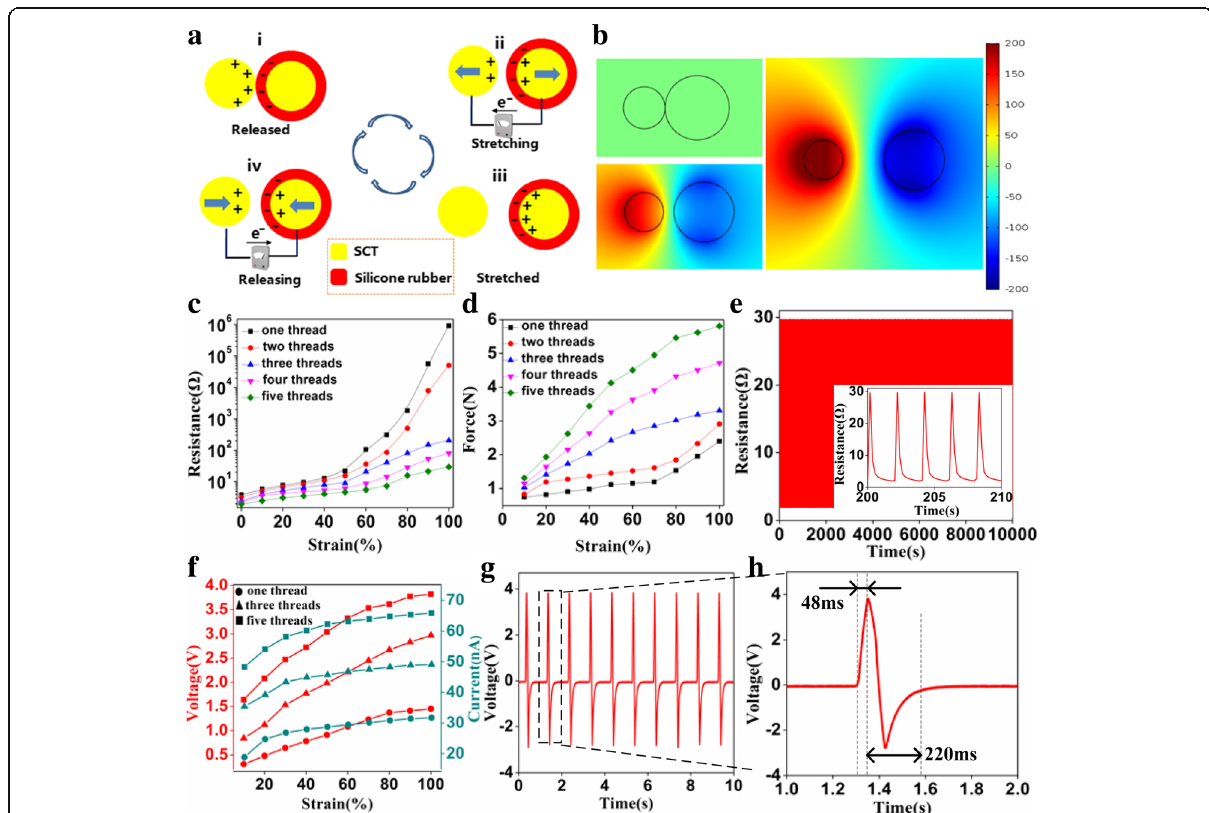
Fig. 2 a Power generation mechanism of SATT at stretching-releasing process. b The simulation results of the potential distributions using COMSOL software. c The resistances of conductive threads with the length of 5 cm at different strain mounts. d The tensile force experienced by different numbers of conductive threads as functions of strain amount. e The tensile durability test of the SCT within 100% strain. f The output voltages and currents of conductive threads at different strain mounts. g The open-circuit voltage of SATT with a length of 5 cm at 100% strain. h Enlarged view of the area indicated by the dashed black box in panel